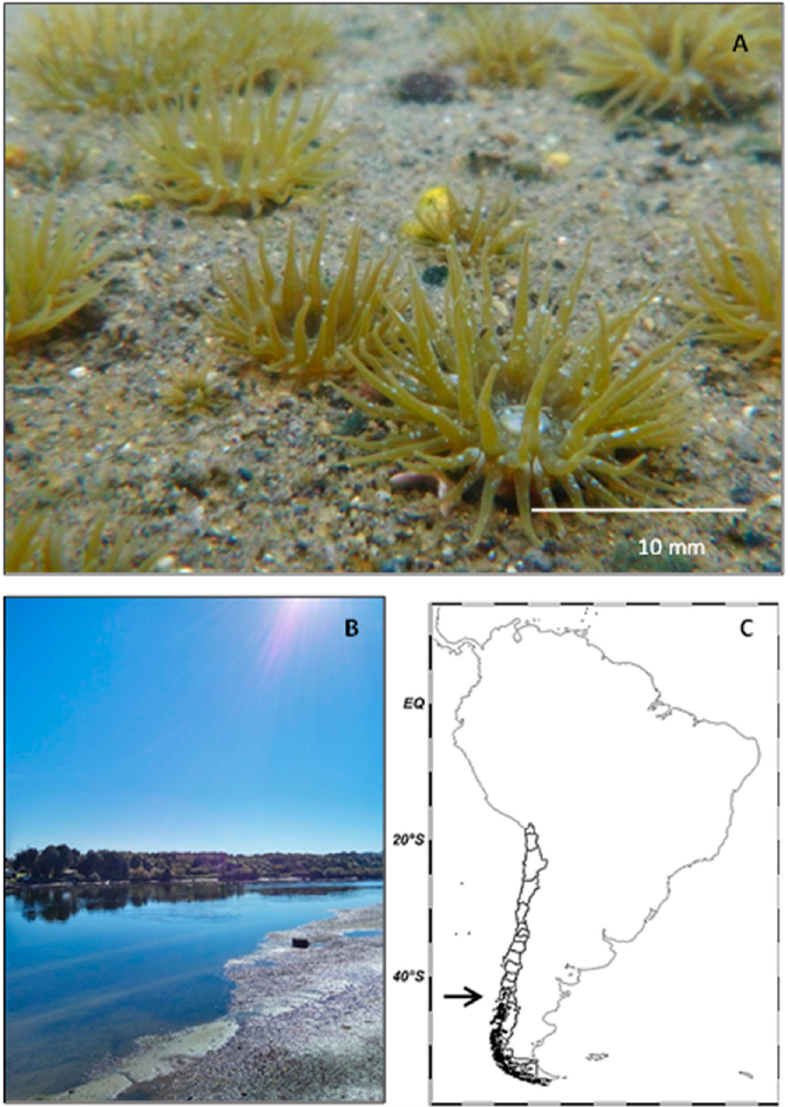
Figure 1. Adult of the estuarine anemone Anthopleura hermaphroditica ( A ) collected from Quempill é n estuary (41 ◦ 520 S; 73 ◦ 460 W) of Chilo é Island ( B ), Southern Chile ( C ). Arrow shows location of Chilo é Island in Chile. Map generated using Ocean Data View software (version 5.6.2, Schlitzer, Reiner, Ocean Data View, odv.awi.de, 2021,